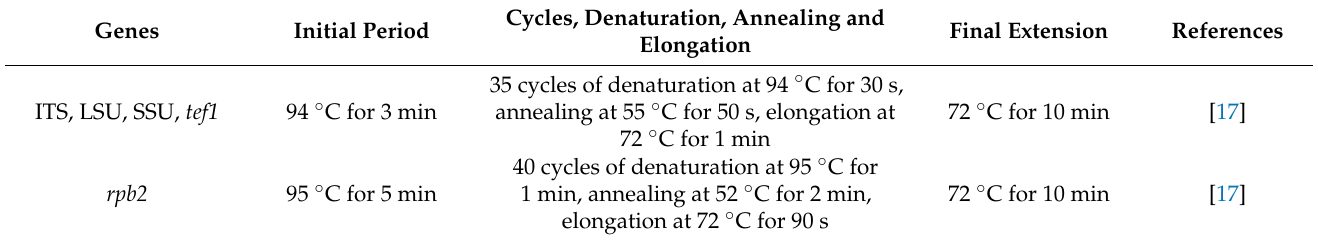
Table 2. ITS, SSU, LSU, tef1, and rpb2 loci PCR conditions.